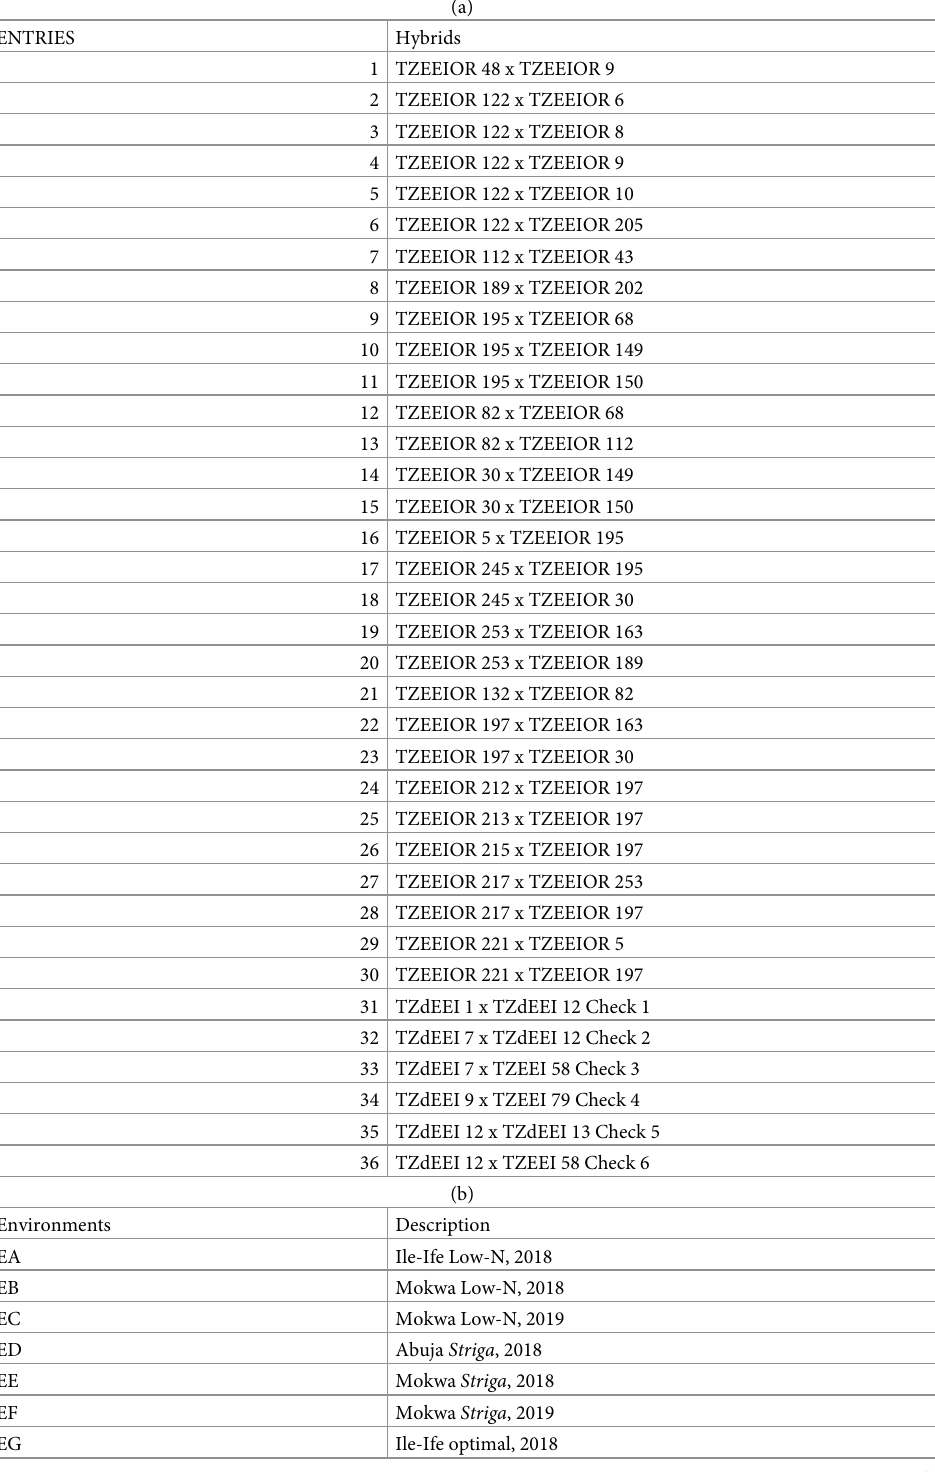
Table 10. (a): List of selected hybrids for stability analysis; (b) The description of the test environments used for the biplot analysis.